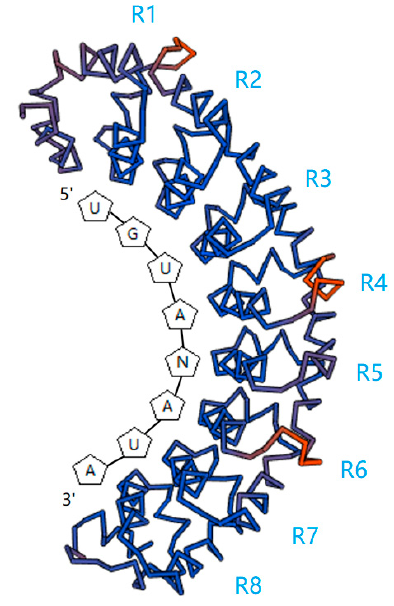
Figure 1. Predictive stick models of the APUM2 ( Arabidopsis thaliana Pumilio 2, AT2G29190) PUM-HD (Pumilio homology domain) bound to its target motif. The analysis result based on the research of Francischini and Quaggio [42]. They showed that the PUM-HD of APUM2 bound to the core nucleotides of 5 ′ -UGUANAUA-3 ′ . The each repeat of PUM-HD bound to corresponding nucleotide through Van der Waals force. The protein structure was generated by SWISS-MODEL (https://swissmodel.expasy.org/) [44–47].